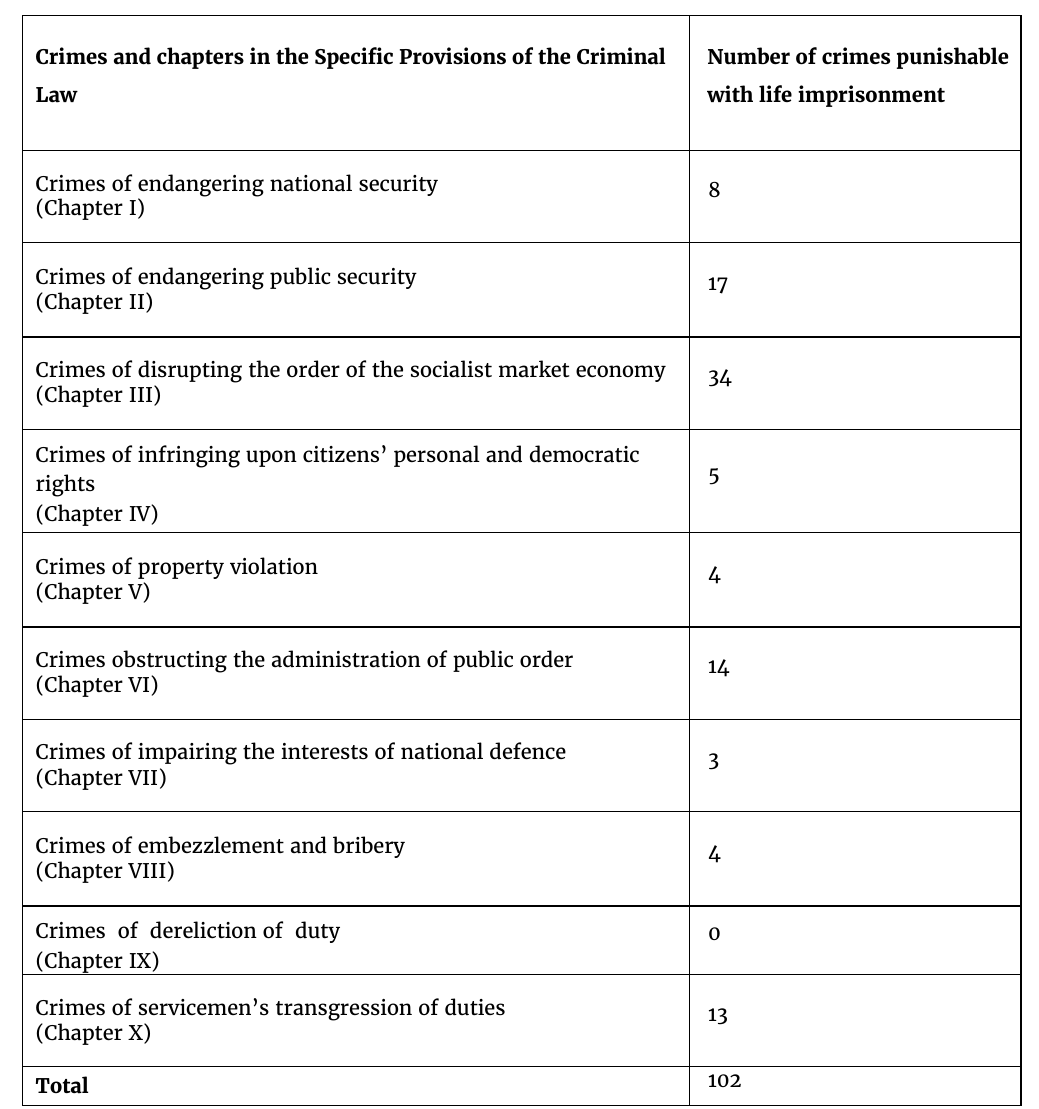
Table 1: 74 The distribution of crimes punishable by life imprisonment.